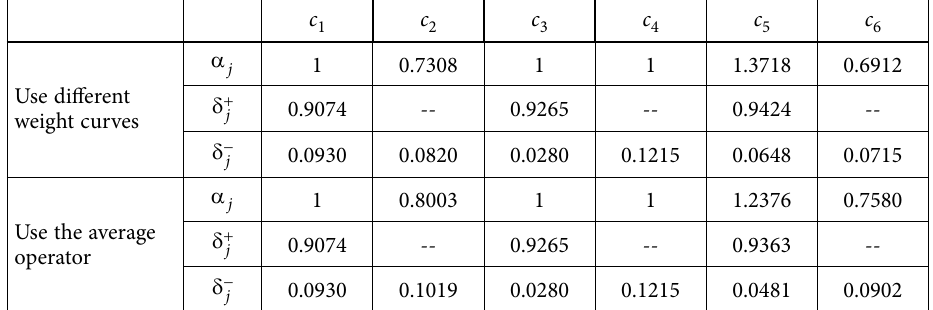
Table 15. The risk attitude coefficients and aspirations under different aggregation of online reviews c